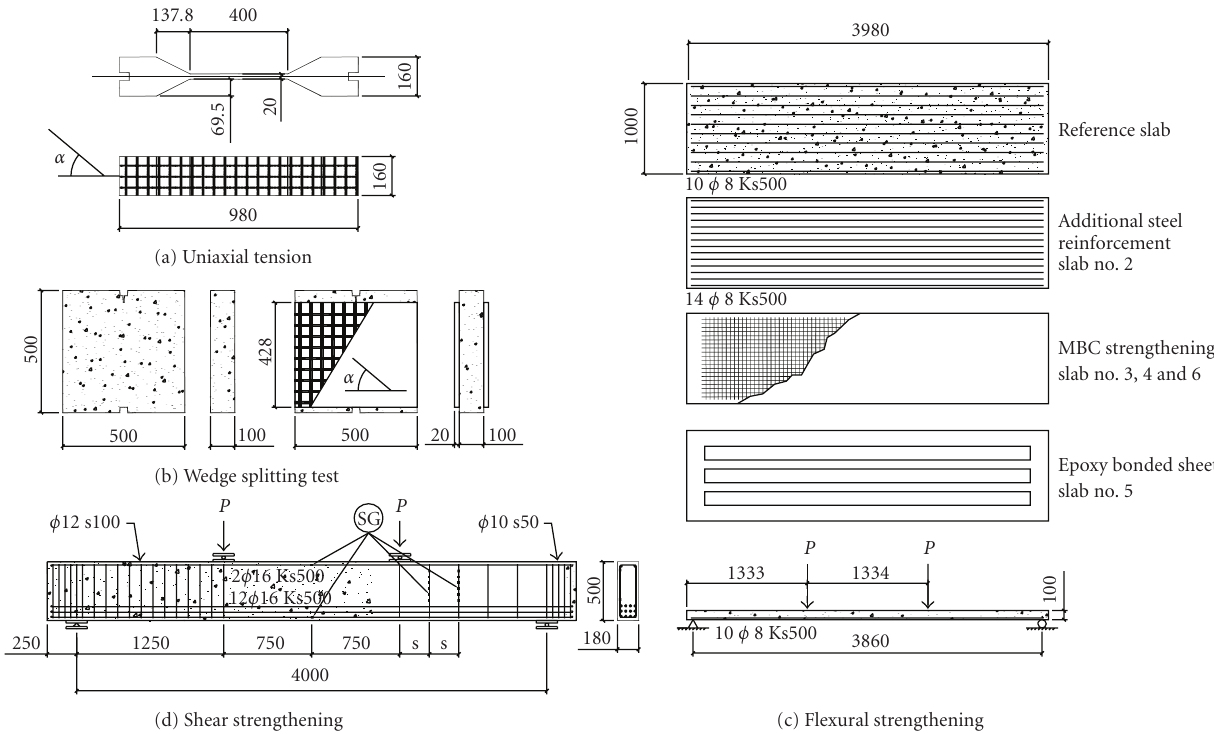
Figure 5: Experimental tests for tensile and fracture behaviour: (a) uniaxial tensile test on dogbones. (b) wedge-splitting test, (c) flexural beams, and (d) shear